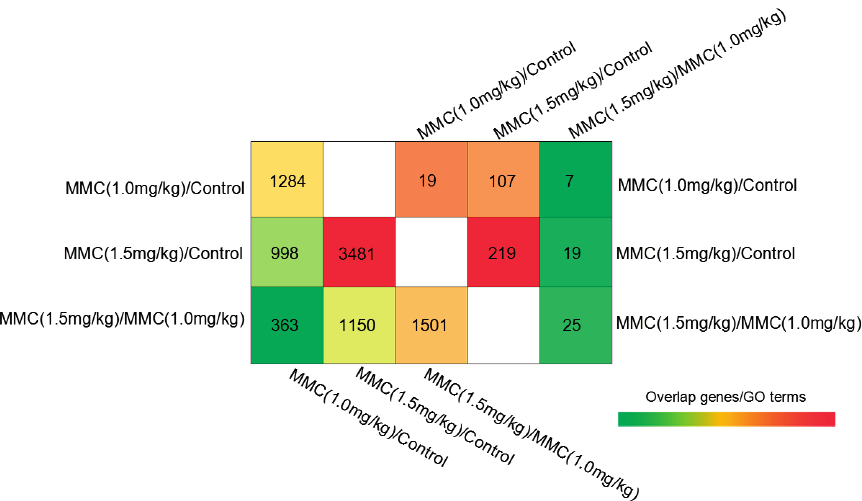
Figure 2. Venn diagram summarizing differentially expressed (DE) genes and gene ontology (GO) in tumor tissues with different treatments. Mice were treated as in Figure 1. Changes in gene expression were determined by cDNA microarray gene profiling. Genes with a false discovery rate (FDR)-adjusted p value ( p < 0.05) and fold change larger than 1.5 were considered as DE genes. Above diagonal-DE genes; below diagonal-GO